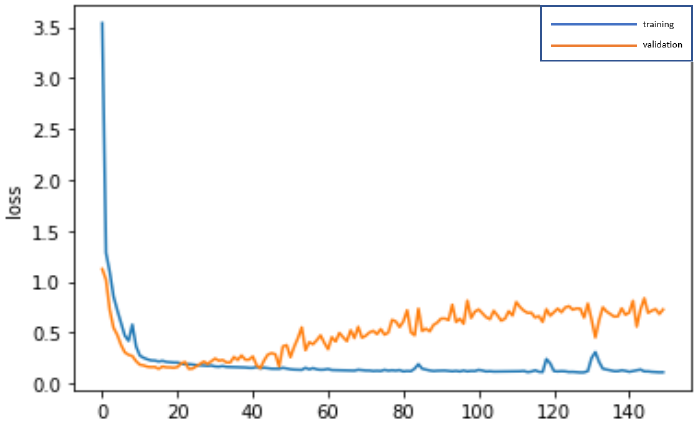
Figure 6. Graph of loss function of the CART-DNN modeling.